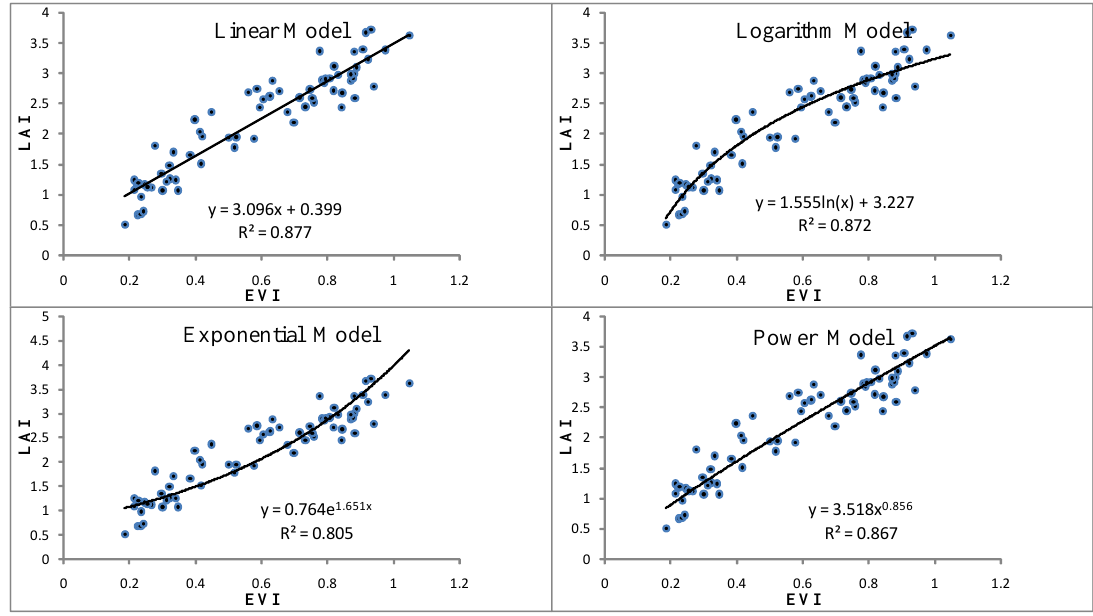
Figure 5. The estimation model of LAI on EVI .